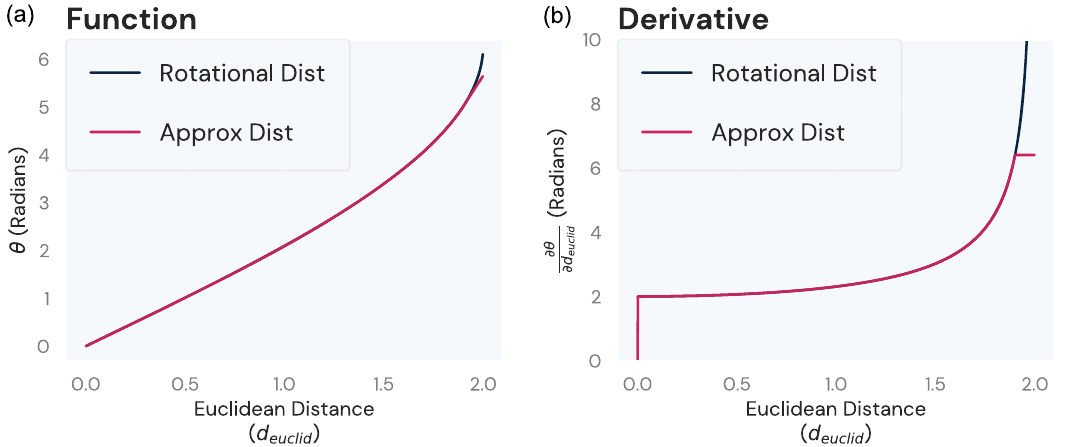
Fig. 3 Approximation of the rotational distance equation. The derivative is not de fi ned at d euclid = 2, so a linear approximation is computed to ensure smooth loss behavior. a Plot of rotational distance functions against euclidean distance. b Plot showing the derivative of rotational distance against euclidean distance, showing